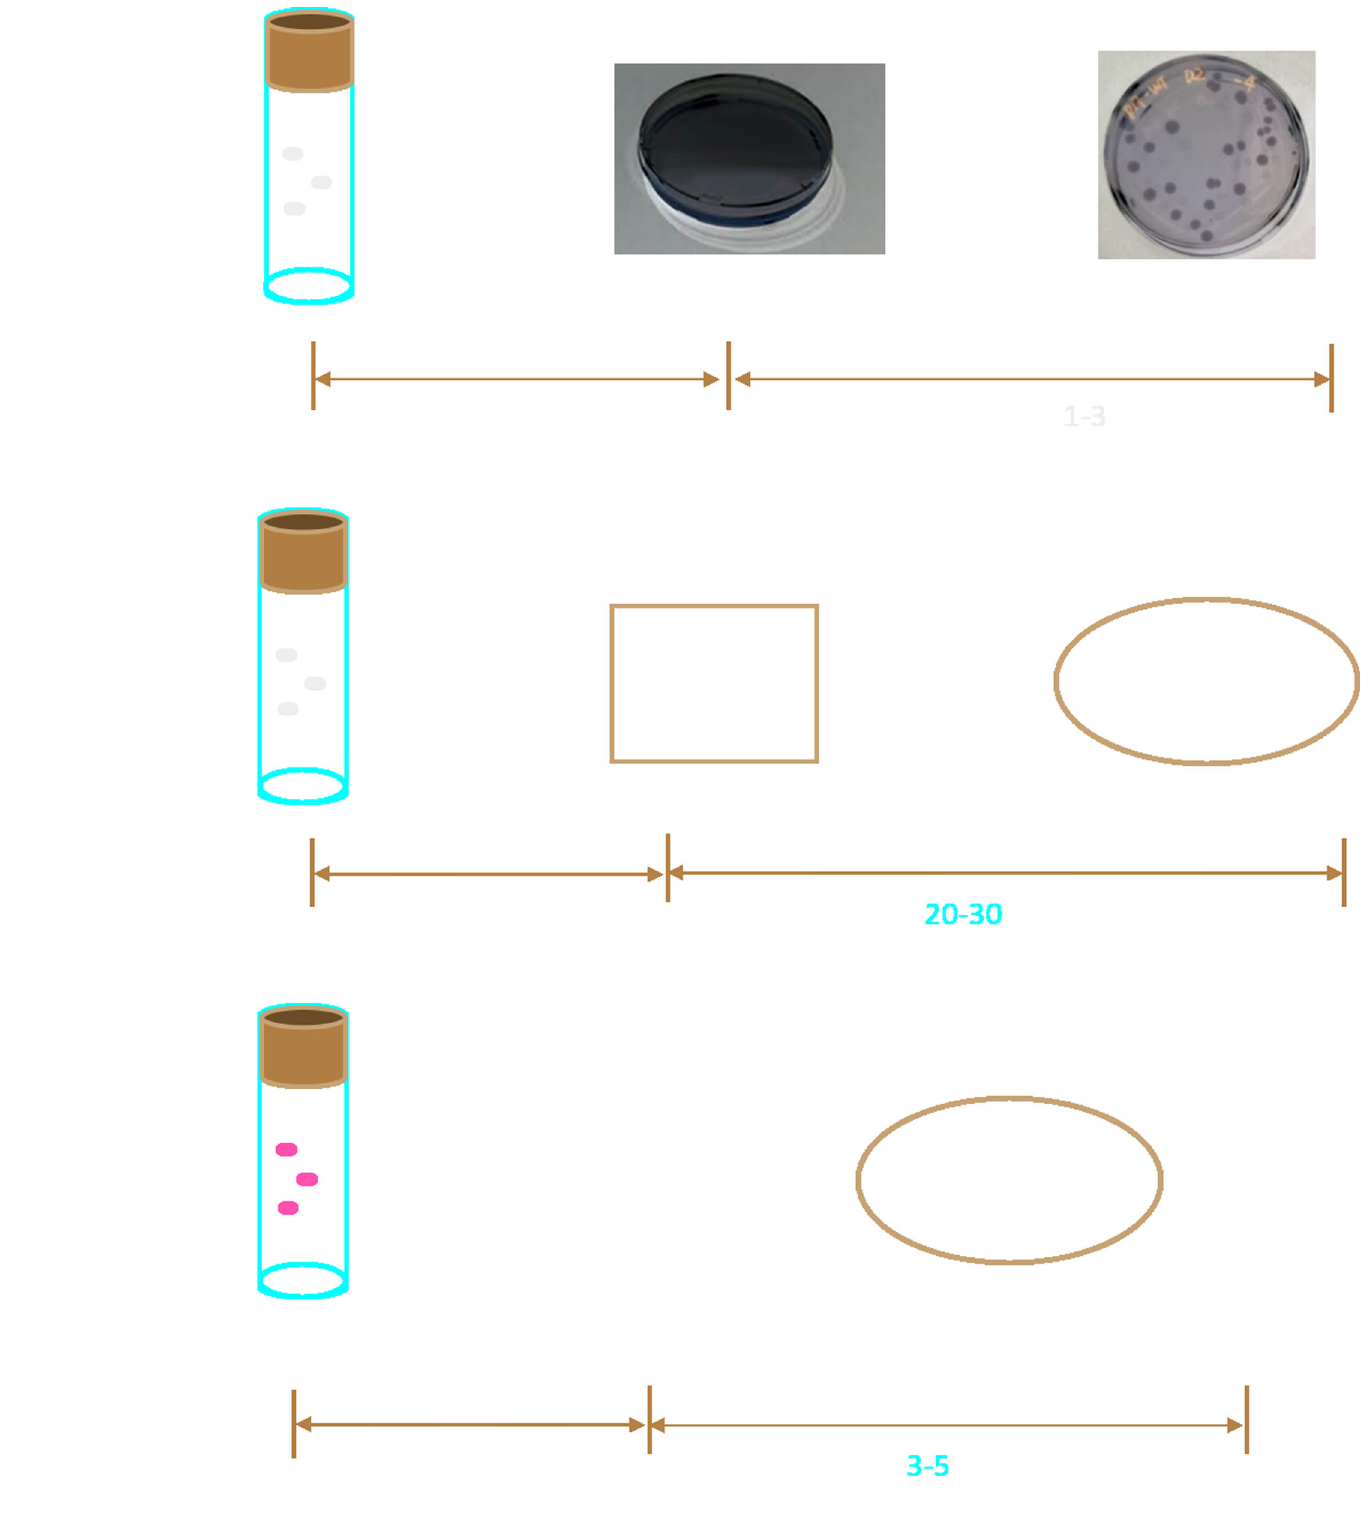
Fig 5. Schematic presentation of our method compared to other methods. A. Conventional method; B, Flow cytometric method with cell staining. C, Our flow cytometric method without cell staining.